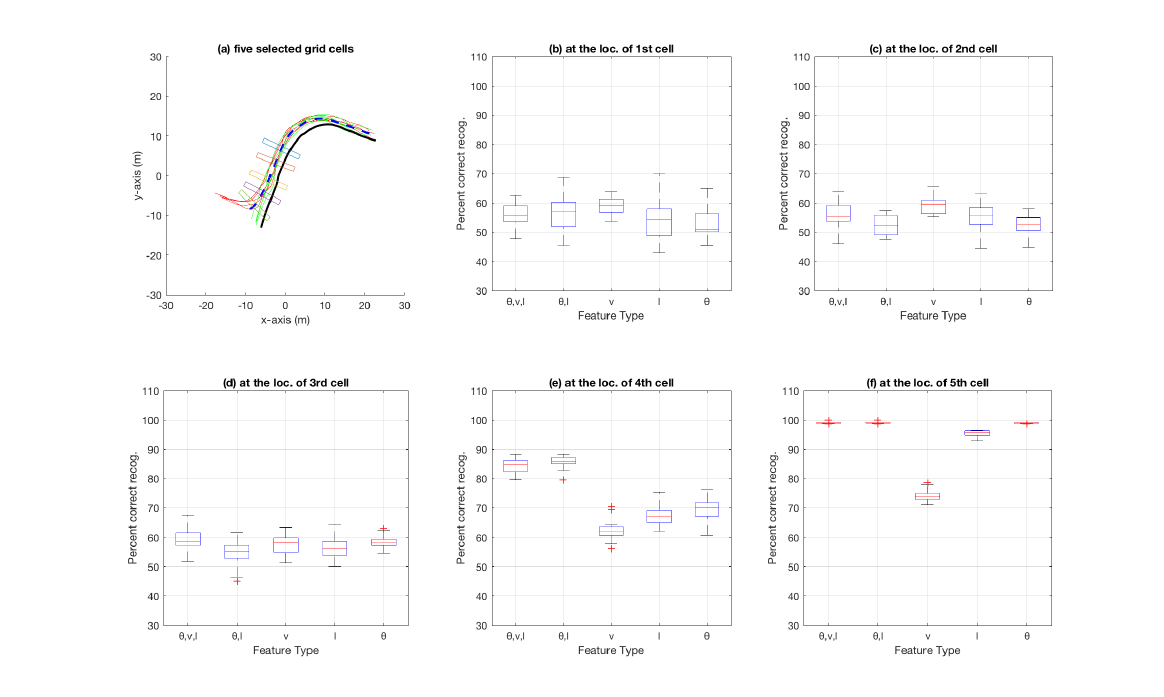
Figure 14. Aggregate results on bicycle dataset using decision trees, with cell width w = 1.2 m.